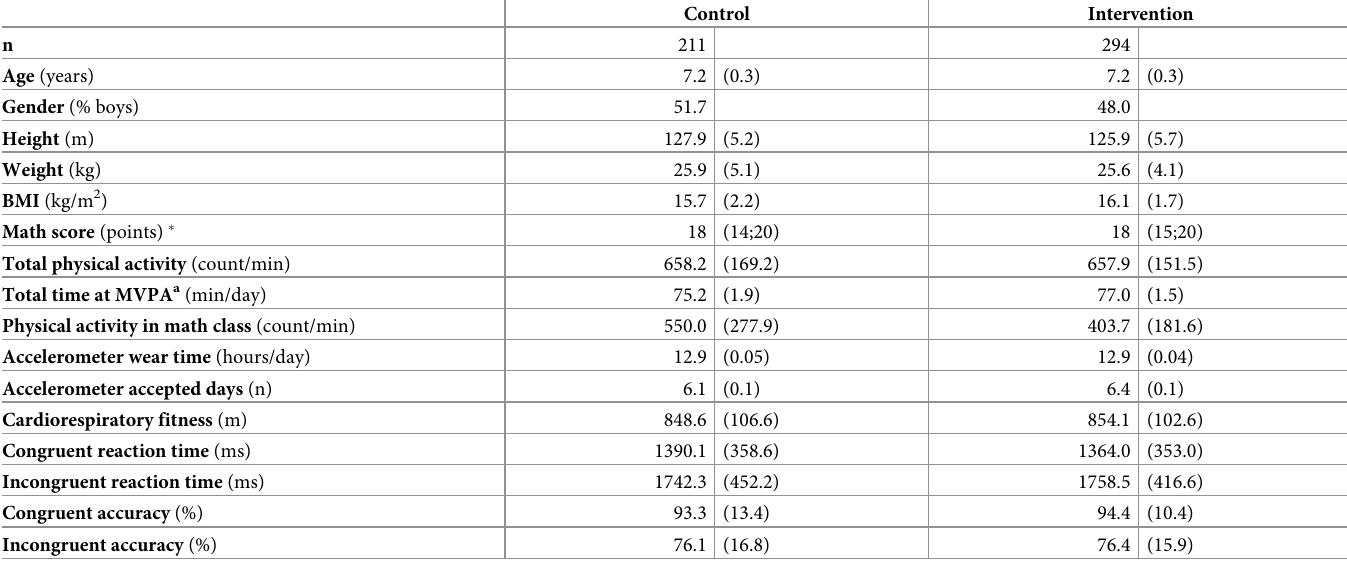
Table 1. Baseline characteristics of the study population.